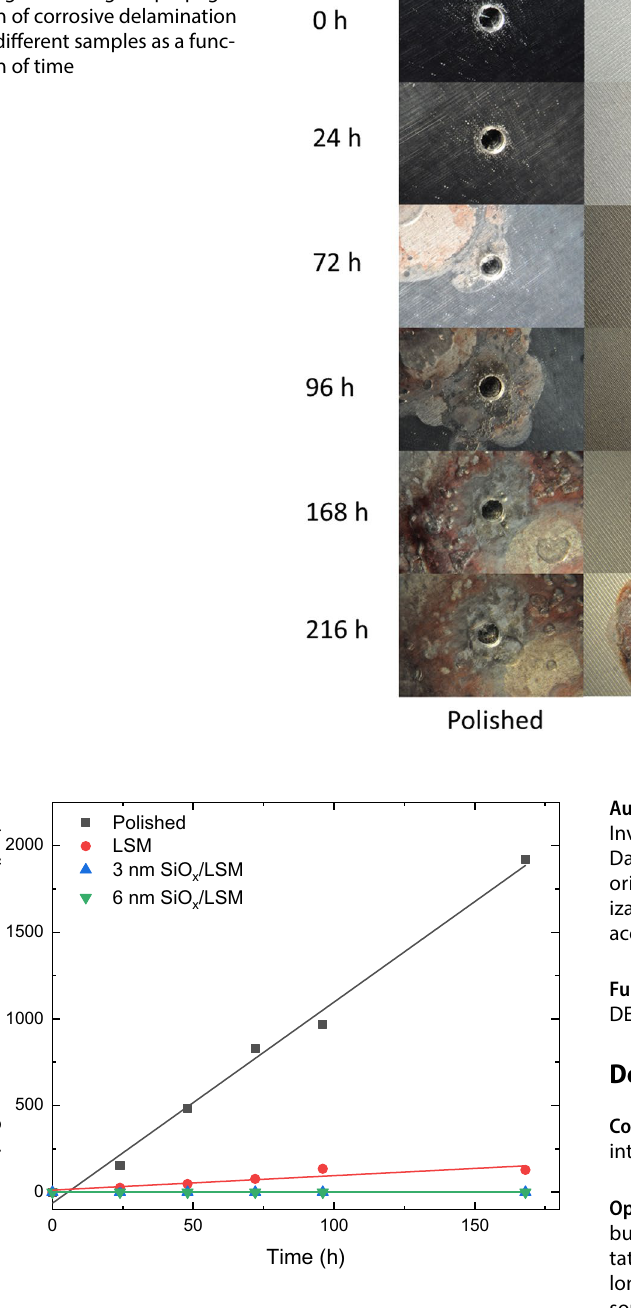
Fig. 9 Optical microscope images showing the propaga- tion of corrosive delamination of different samples as a func- tion of time